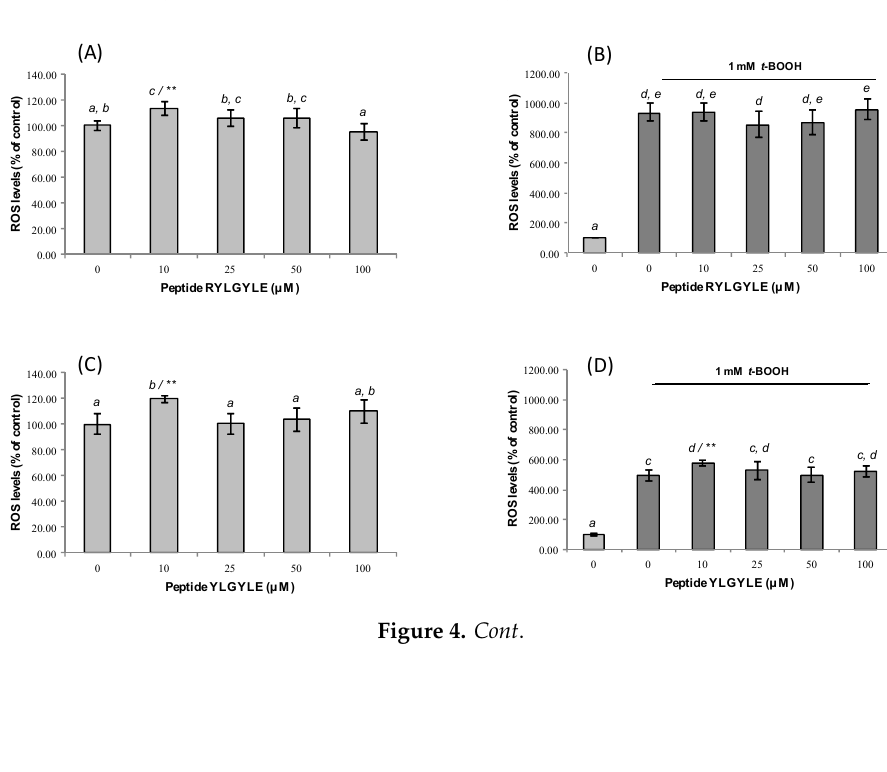
Figure 4. Dose-dependent effects of synthetic animal-protein derived peptides ( A , B ) RYLGYLE, ( C , D ) YLGYLE, ( E , F ) YFYPEL, and ( G , H ) YPWT on ROS production in non-stressed macrophages RAW264.7 (A,C,E,F) and macrophages RAW264.7 stressed with tert-butyl hydroperoxide ( t -BOOH, 0.25 mM). Cells were pre-treated with peptides at concentrations that ranged from 10 to 100 μ M for 24 h. Results were expressed as percentage of ROS levels compared to control, which was considered as 100% (% control, mean ± standard deviation (SD), n = 3. Different letters indicate significant differences ( p < 0.05) and *** ( p < 0.001); ** ( p < 0.01); * ( p < 0.05) significant differences of each concentration versus control under the same experimental conditions (one-way ANOVA followed by Tukey’s multiple comparison test).